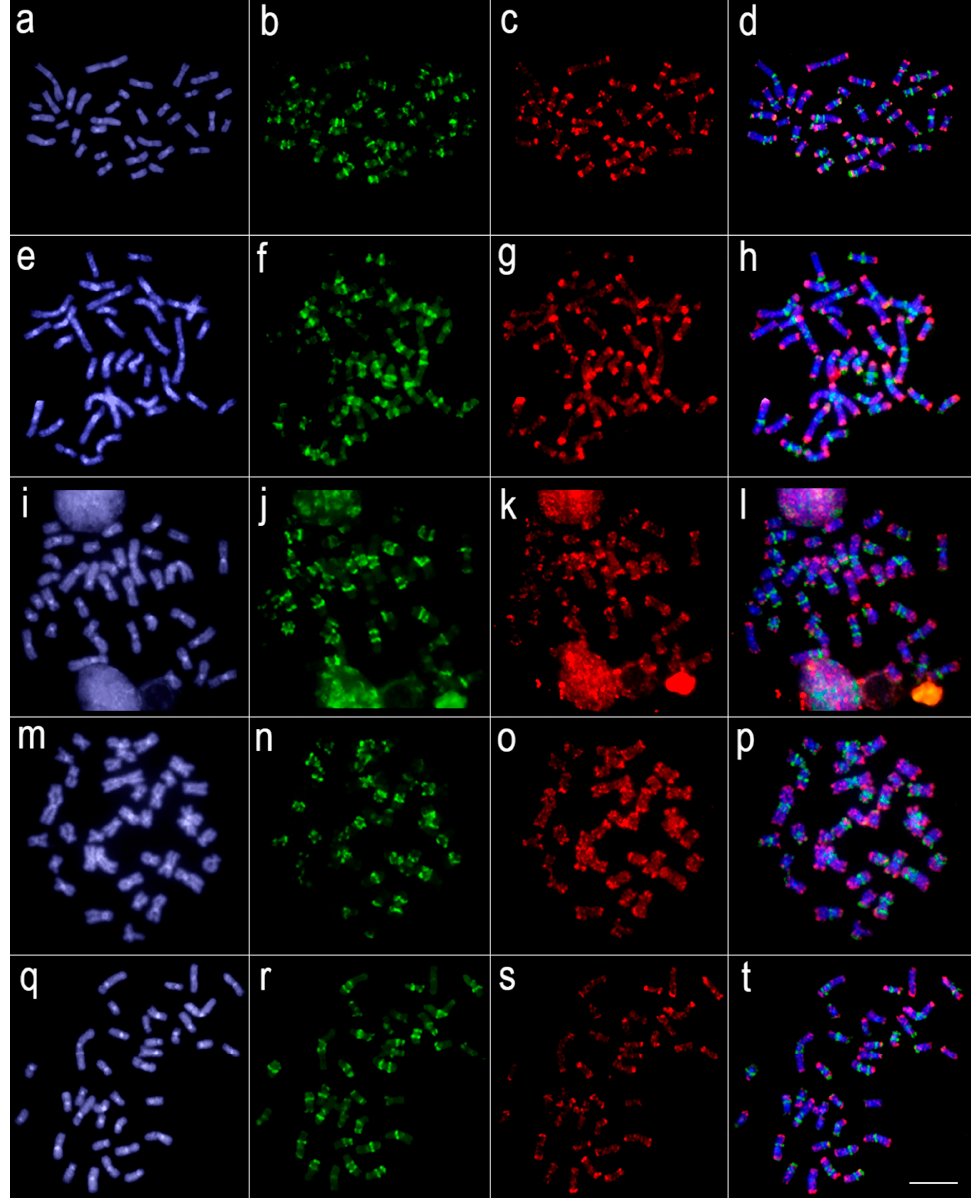
Figure 5. Comparative genomic hybridization among Lebiasina melanoguttata and Nannostomus species. Genomic probes from L. melanoguttata and N. unifasciatus hybridized against L. melanoguttata chromosomes ( a – d ). Genomic probes from L. melanoguttata , and N. trifasciatus hybridized against L. melanoguttata chromosomes ( e – h ). Genomic probes from L. melanoguttata , and N. beckfordi hybridized against L. melanoguttata chromosomes ( i – l ). Genomic probes from L. melanoguttata and N. eques hybridized against L. melanoguttata chromosomes ( m – p ). Genomic probes from L. melanoguttata and N. marginatus hybridized against L. melanoguttata chromosomes ( q – t ). The first column ( a , e , i , m , q ): DAPI images (blue); second column ( b , f , j , n , and r ): hybridization patterns using gDNA probe from L. melanoguttata ; third column ( c , g , k , o and s ): hybridization patterns using gDNA probes from N. unifasciatus , N. trifasciatus , N. beckfordi , N. eques , and N. marginatus , respectively; fourth column ( d , h , l , p , and t ) merged images of both genomic probes and DAPI staining depicting the shared regions in yellow. Scale bar = 5 μ m.